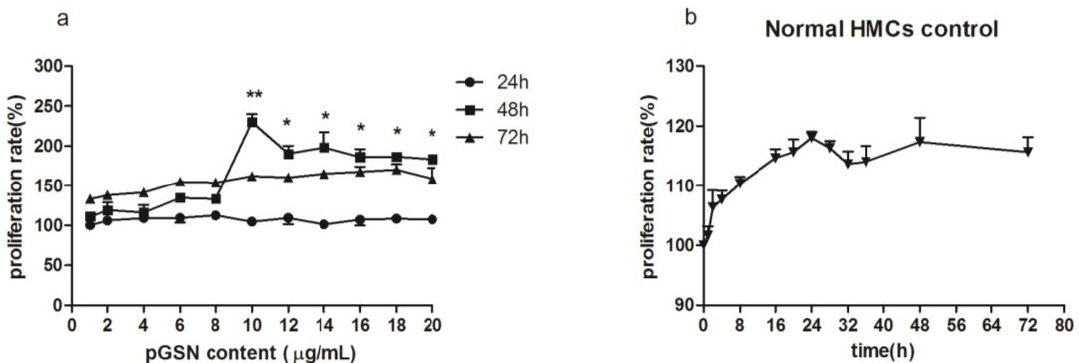
Figure 1. The comparison of human mesangial cells (HMCs) proliferation, which were incubated with different time and content of pGSN, and normal HMCs as control (incubated with RPMI 1640 medium). ( a ) The most significant increased proliferation rate of HMCs was observed at the point of culture with pGSN in 10 µg/mL and 48 h, when compared with any other different conditions(** p < 0.01). HMCs cultured with48 handmore than 10 µg/mL pGSN had a slightly decreased proliferation rate, but still higher than other conditions (* p < 0.05); ( b ) Normal HMCs cultured with 1640 medium from 0 to 72 h was performed as a pGSN control, which showed no different proliferation rates at 24 and 72 h ( p > 0.05), but significantly decreased with the 48 h group(** p < 0.01 with 10 µg/mL and * p < 0.05 with 10–20 µg/mL pGSN). Every sample in this MTT (3-(4,5-dimethylthiazol-2-yl)-2,5- diphenyltetrazolium bromide) experiment has three repeated experimental data ( n = 3), the between- group differences were calculated with a one-way ANOVA and LSD (least-significant difference) test, and the results were presented as means ± standard deviation (SD).